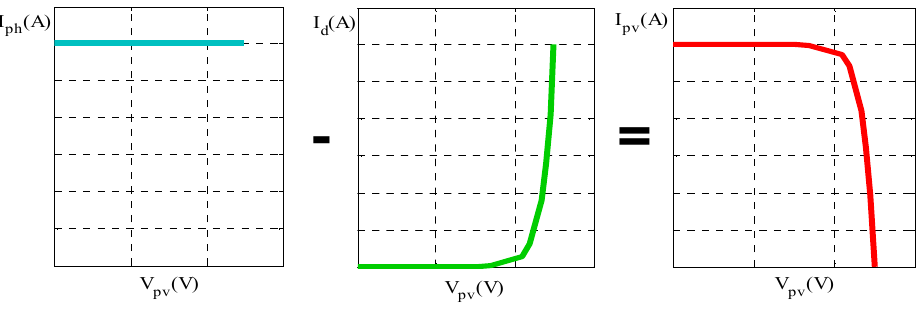
Figure 4. Photocurrent and diode current superposition.